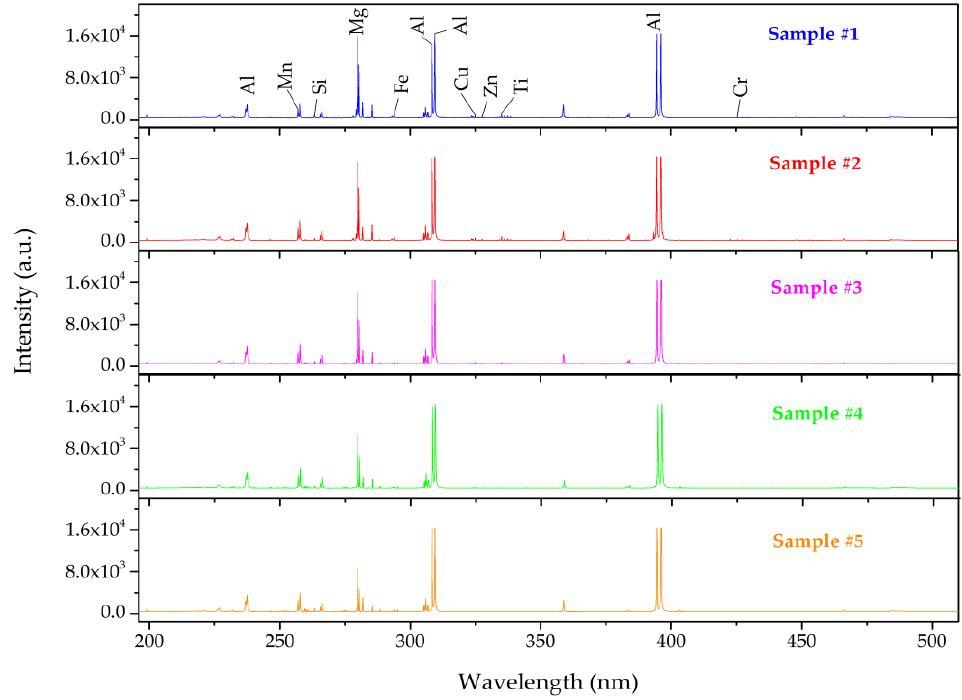
Figure 2. Average LIBS spectra of the five aluminum alloys.